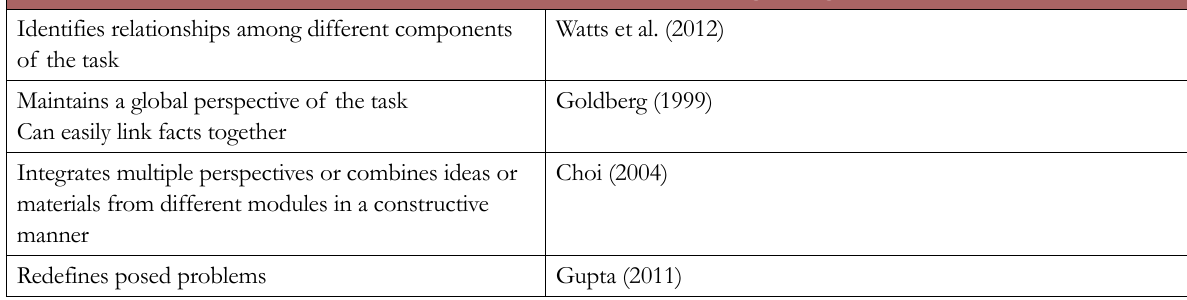
Table 9. Behaviours showing “globalizing”